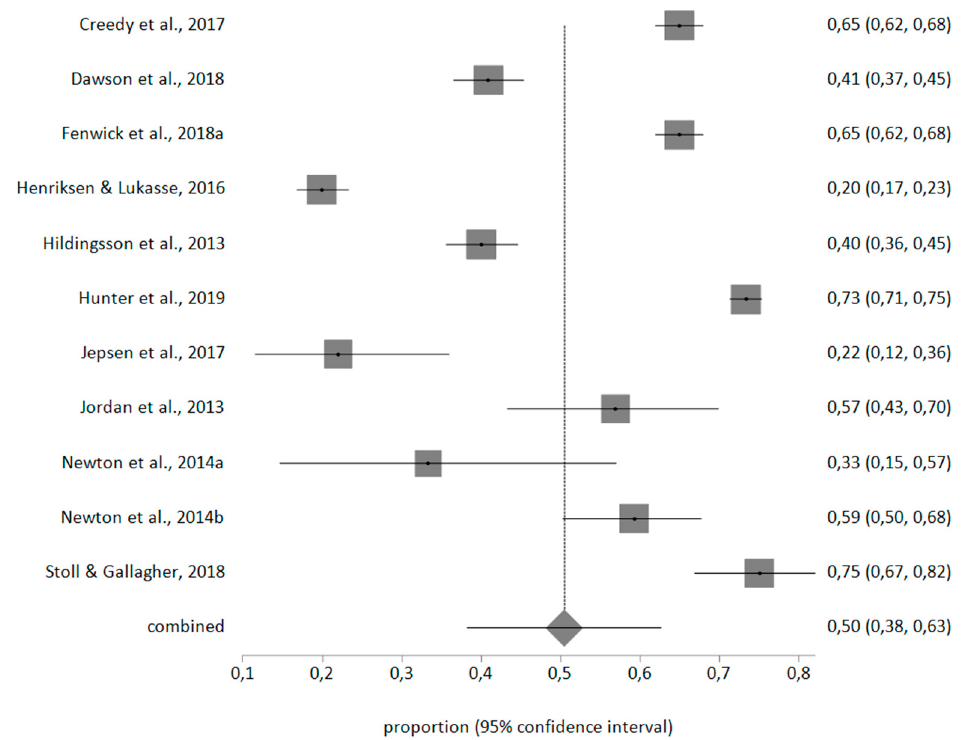
Figure 2. Forest plot of personal-related burnout prevalence.